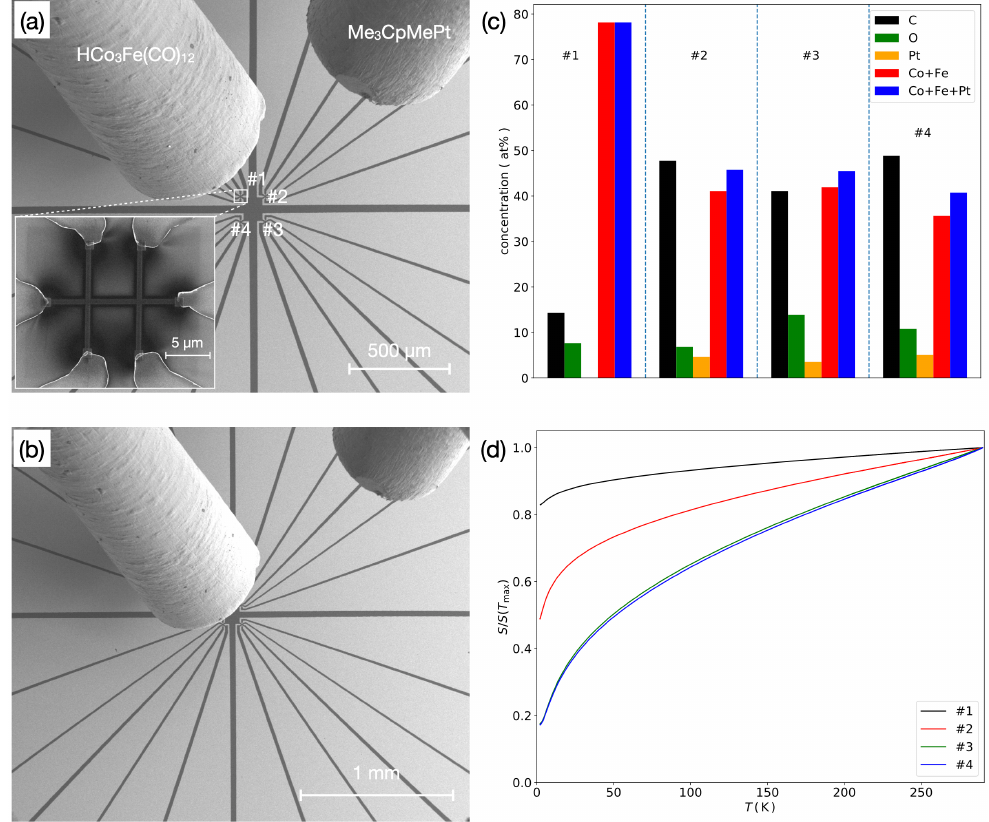
Figure 1. ( a ) SEM image of deposition region showing two gas injectors for the the precursor as indicated. Inset: Enlarged view of deposition area #1 with Cr/Au six-probe electrode structure and granular ferromagnet (GFM) deposit (dark contrast). ( b ) SEM image of injectors with Pt-precursor injector retracted for lower Pt content of GFM deposit. ( c ) GFM composition from EDX analysis of four different samples deposited on one chip at the four positions indicated in ( a ). ( d ) Plot of temperature- dependent conductance normalized to values at 295K for four GFM samples as